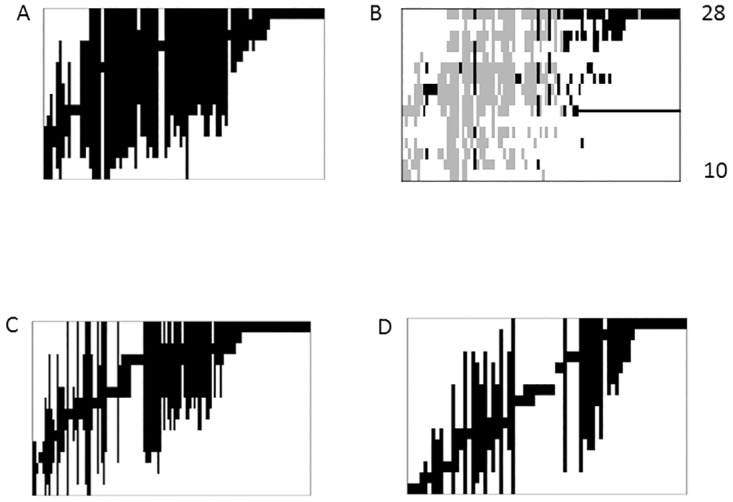
Sorted site-by-species incidence matrices for invertebrate species in 16 estuaries, with species on the x-axis and sites (estuaries) on the y-axis.Matrices for HD trait (A), ID trait (C) and LD trait (D) result from reciprocal averaging and show species ranges (black columns) hiding embedded absences. Matrix B shows the incidence matrix for the HD trait with the species ordered as in matrix A and with sites (estuaries) ordered after falling salinity from the top and with gradient end values indicated. Horizontal solid line indicates the 18 psu limit. Species recorded from the low saline SW Baltic Sea, south of the Danish Straits, are indicated by grey boxes. Black boxes indicate species never recorded south of the Danish straits i.e. at salinities < ca. 18 psu. Matrices with estuary id and species names are given in S2 File.